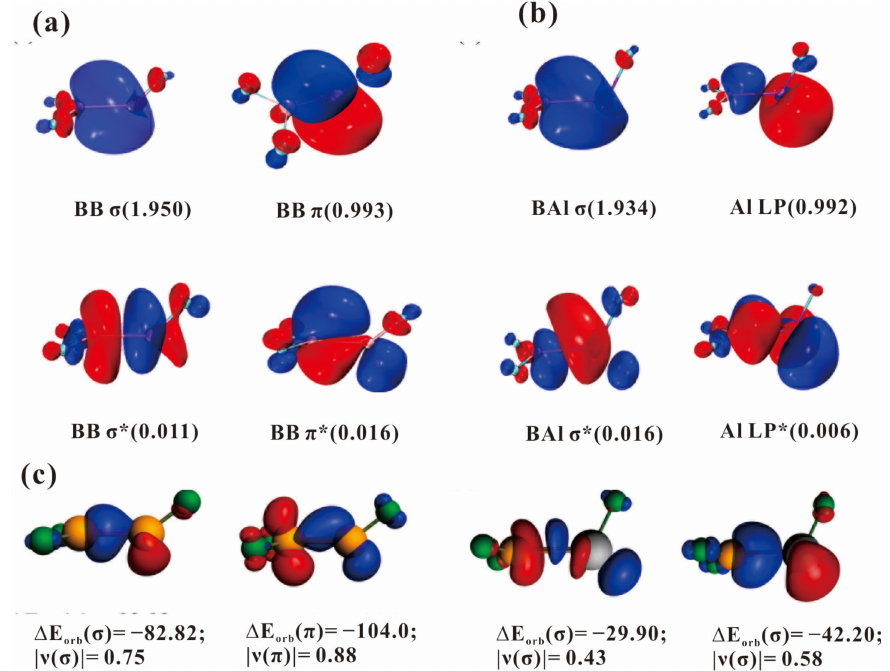
Figure 6. ( a ) The active molecular orbitals of F 2 BBF at CASSCF (3e, 8o)/def2-TZVP level. The isosurface value is 0.04 a.u. MO occupation numbers are given with each orbital; ( b ) The active molecular orbitals of F 2 BAlF at CASSCF (3e, 8o)/def2-TZVP level. The isosurface value is 0.04 a.u. MO occupation numbers are given with each orbital; ( c ) Plot of the deformation densities ∆ ρ of the F 2 B → BF σ donation and BF → BF 2 π back-donation in F 2 BBF with the associated interaction energy ∆ Eorb and charge eigenvalues | ν n |(in e). The charge flow is from red → blue; ( d ) Plot of the deformation densities ∆ ρ of the F 2 B → AlF σ donation and AlF → BF 2 σ back-donation in F 2 BAlF with the associated interaction energy ∆ Eorb and charge eigenvalues | ν n |(in e). The charge flow is from red →